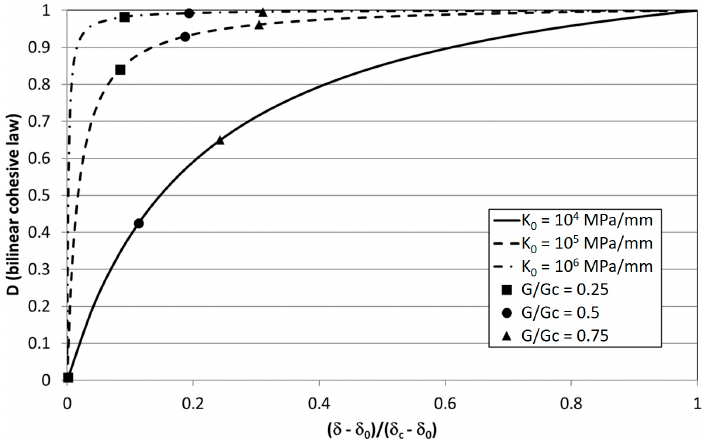
Figure 7. Evolution of quasi-static damage, Equation (1), for different values of K 0 and σ 0 = 30 MPa. Dots represent the transition point between quasi-static (“critical”) and subcritical fatigue damage evolution.